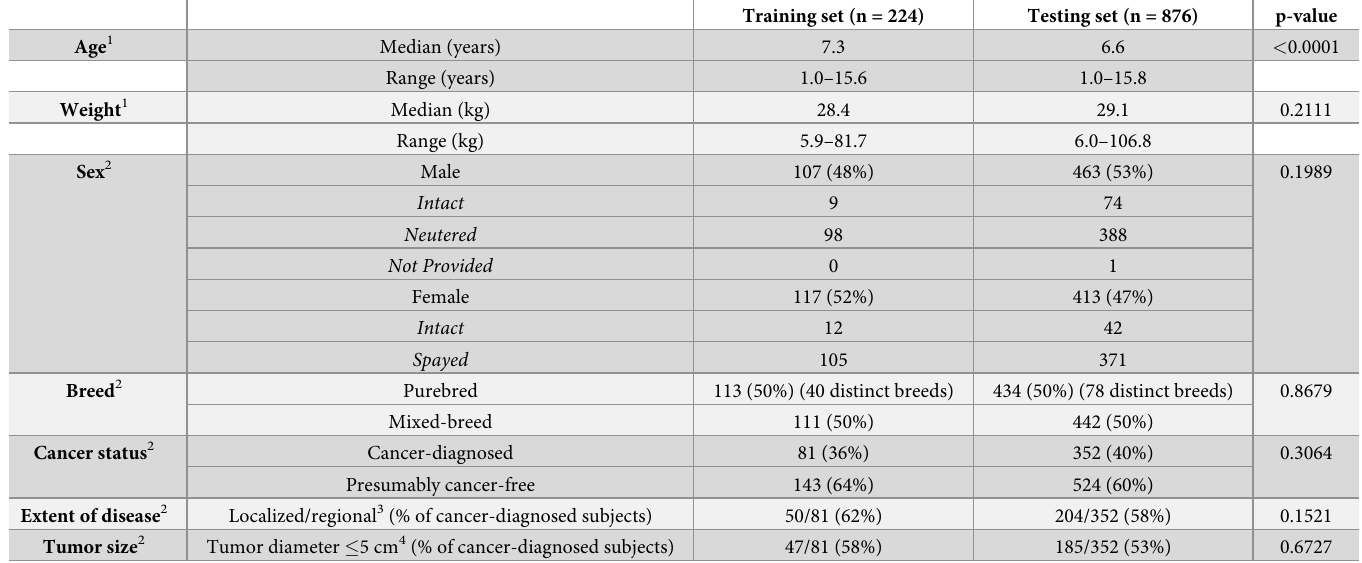
Table 1. Comparison of subject demographics and cancer characteristics for the training and testing